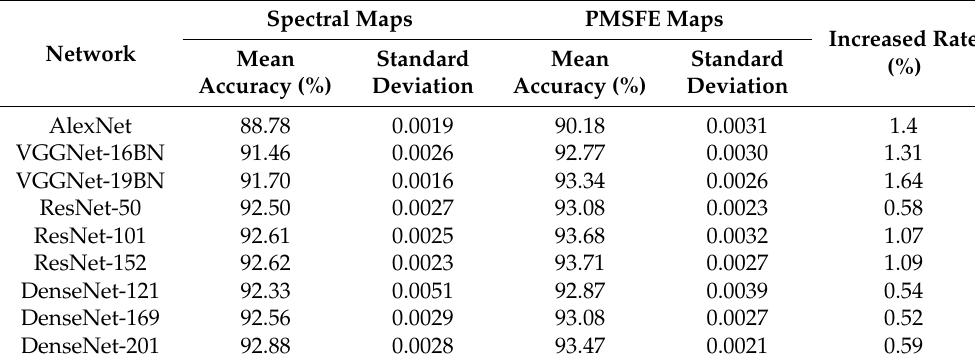
Table 2. The accuracy of spectral maps and PMSFE maps across all networks and the rate of increase after using PMSFE